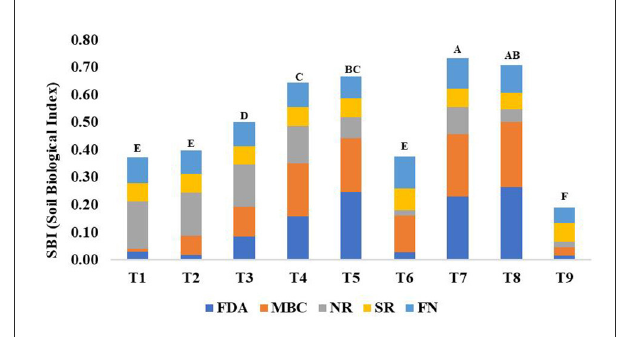
FIGURE5 Effect of different tillage and residue management practices on soil biological index and the individual contribution of each of the key indicators. T1: reduced till direct seeded rice–zero till barley (RTDSR–ZTB), T2: reduced till direct seeded rice–zero till barley–green gram (RTDSR–ZTB–Gg), T3: zero till direct seeded rice–zero till barley–zero till green gram (ZTDSR–ZTB–ZTGg), T4: